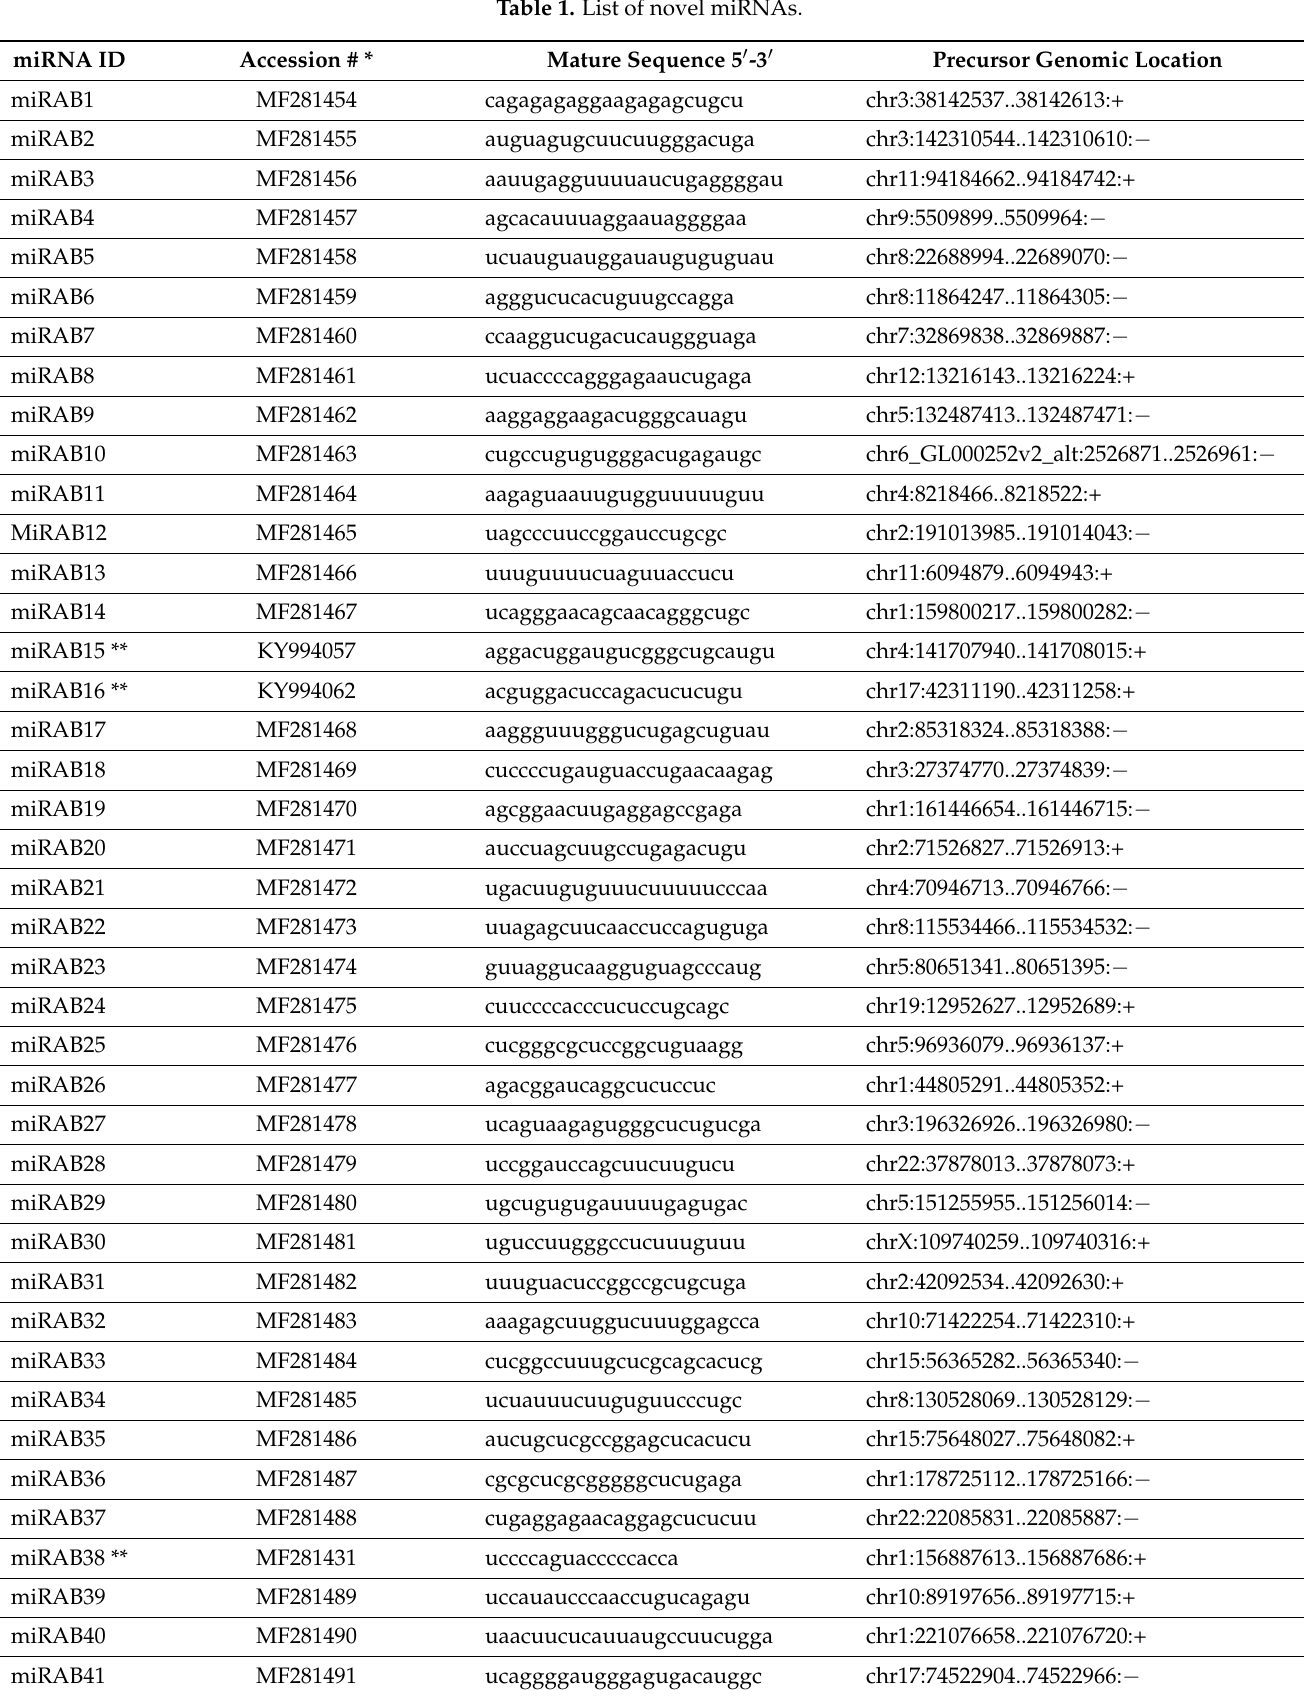
Table 1. List of novel